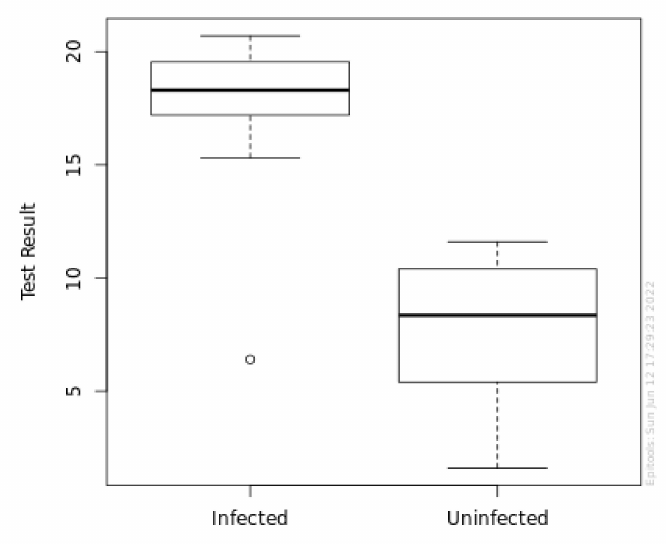
Figure 3. Box plot of a-MMP-8 levels in P+ group (infected) and P − group (uninfected). Figures 4 and 5 provide the sensitivity and specificity graph for the a-MMP-8 level at T1 and the area under the ROC curve for a-MMP-8 at T1 (95% CI for AUC),